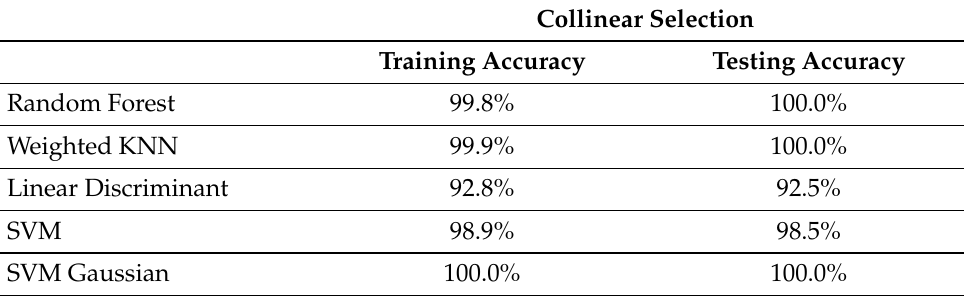
Table 5. Accuracy rate for model with multicollinearity feature selection.